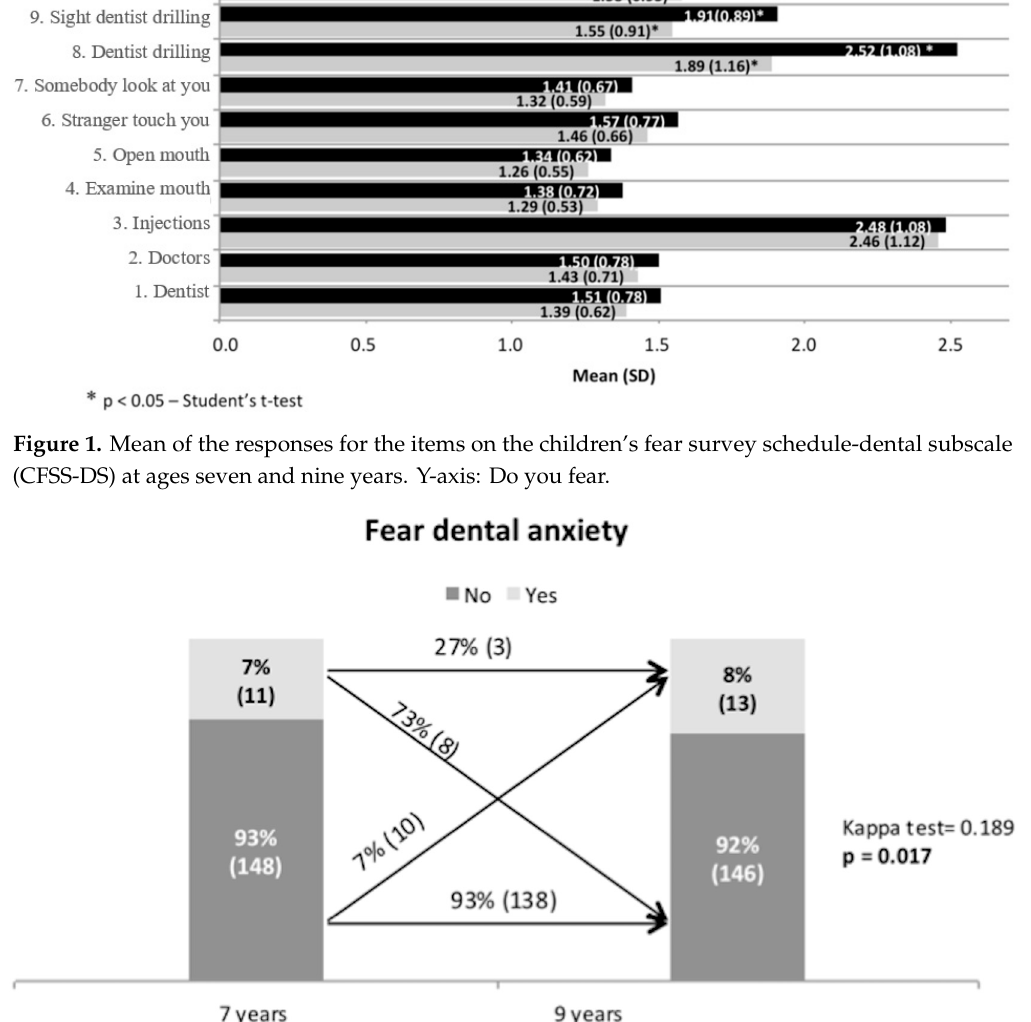
Figure 2. Change in dental fear and anxiety (DFA) between seven and nine years.